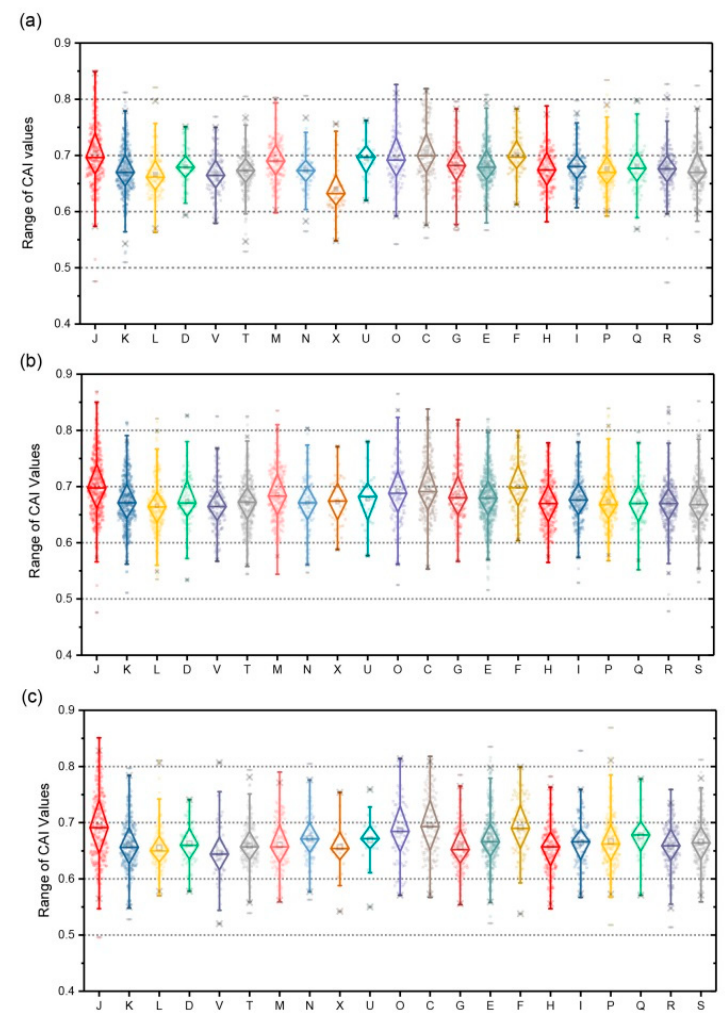
Figure 7. ( a ) Ranges of Codon Adaption Index (CAI) values of di ff erent genes in the genome of L. pakistanensis LZH-9 based on COG classification. ( b ) Ranges of CAI values of di ff erent genes in the genome of L. pakistanensis JCM 18,776 based on COG classification. ( c ) Ranges of CAI values of di ff erent genes in the genome of Lysinibacillus sp. UBA7518 based on COG classification. (COG